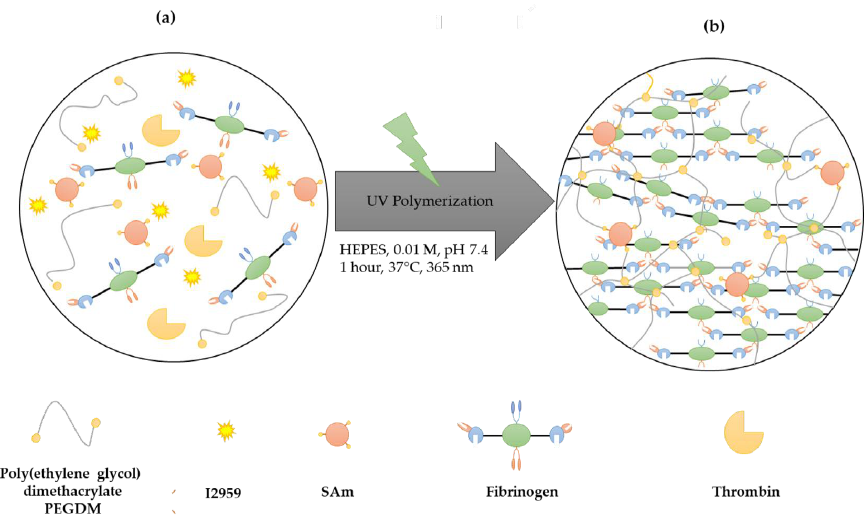
Figure 1. Scheme of interpenetrating polymer network (IPN) synthesis. ( a ) All the precursors are mixed together at the same time; ( b ) fibrin/polyethylene oxide (PEO)-serum albumin functionalized with methacrylate residues (SAm)-based IPNs are obtained after UV exposure (1.16 mW/cm 2 , 365 nm) for 1 h at 37 °C.